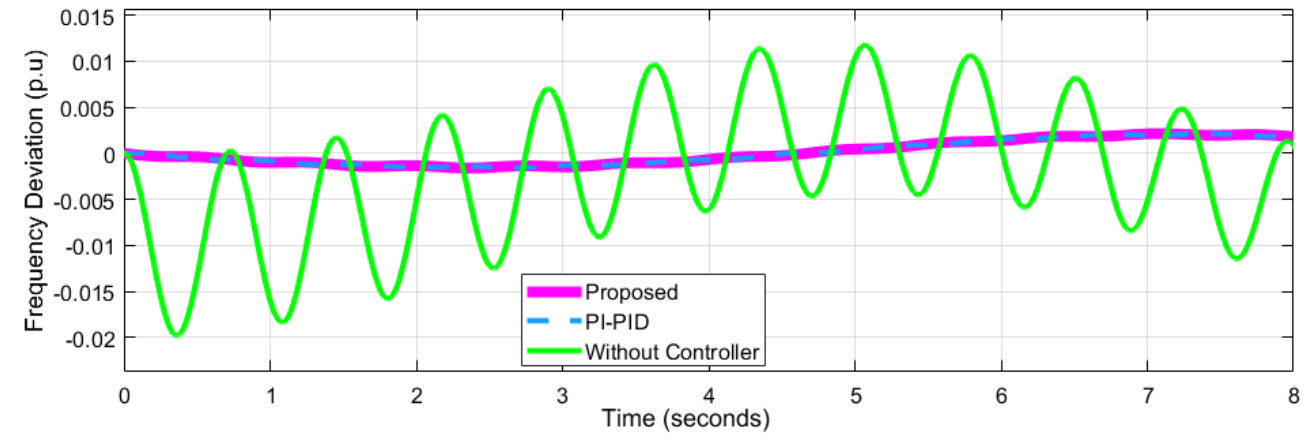
Figure 13. Case 3: frequency deviation at (K p = −1.8914, K i = −0.0007) for network 3.